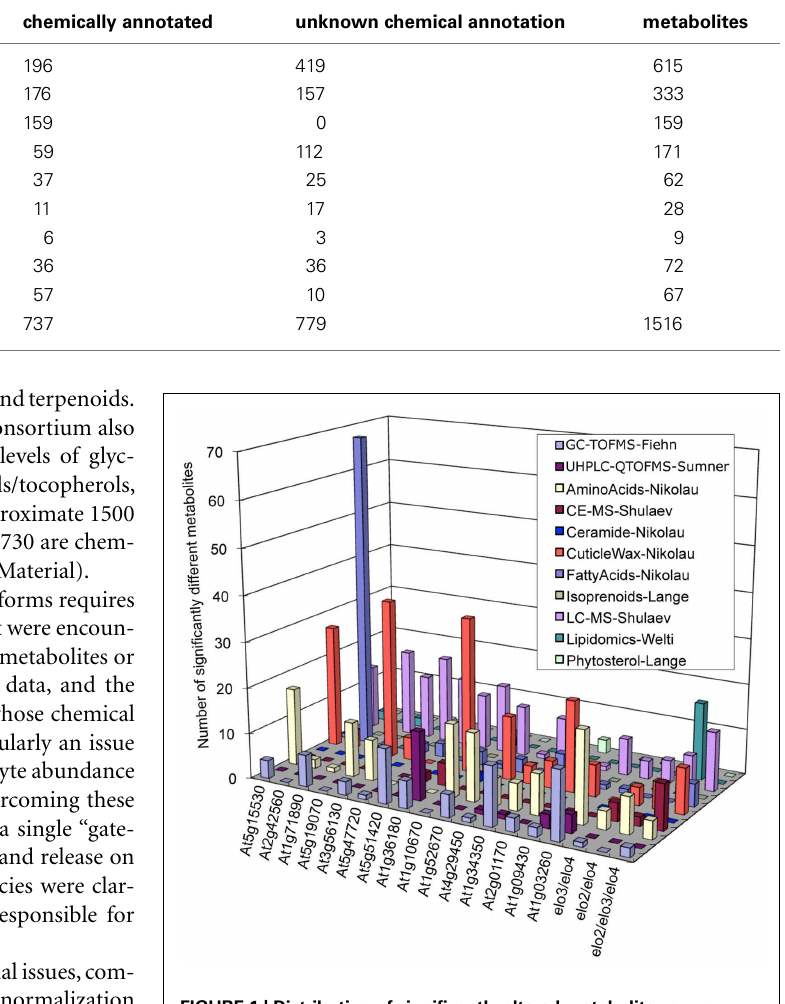
FIGURE 1 | Distribution of significantly altered metabolites among different mutants as detected by different analytical platforms (identified in the